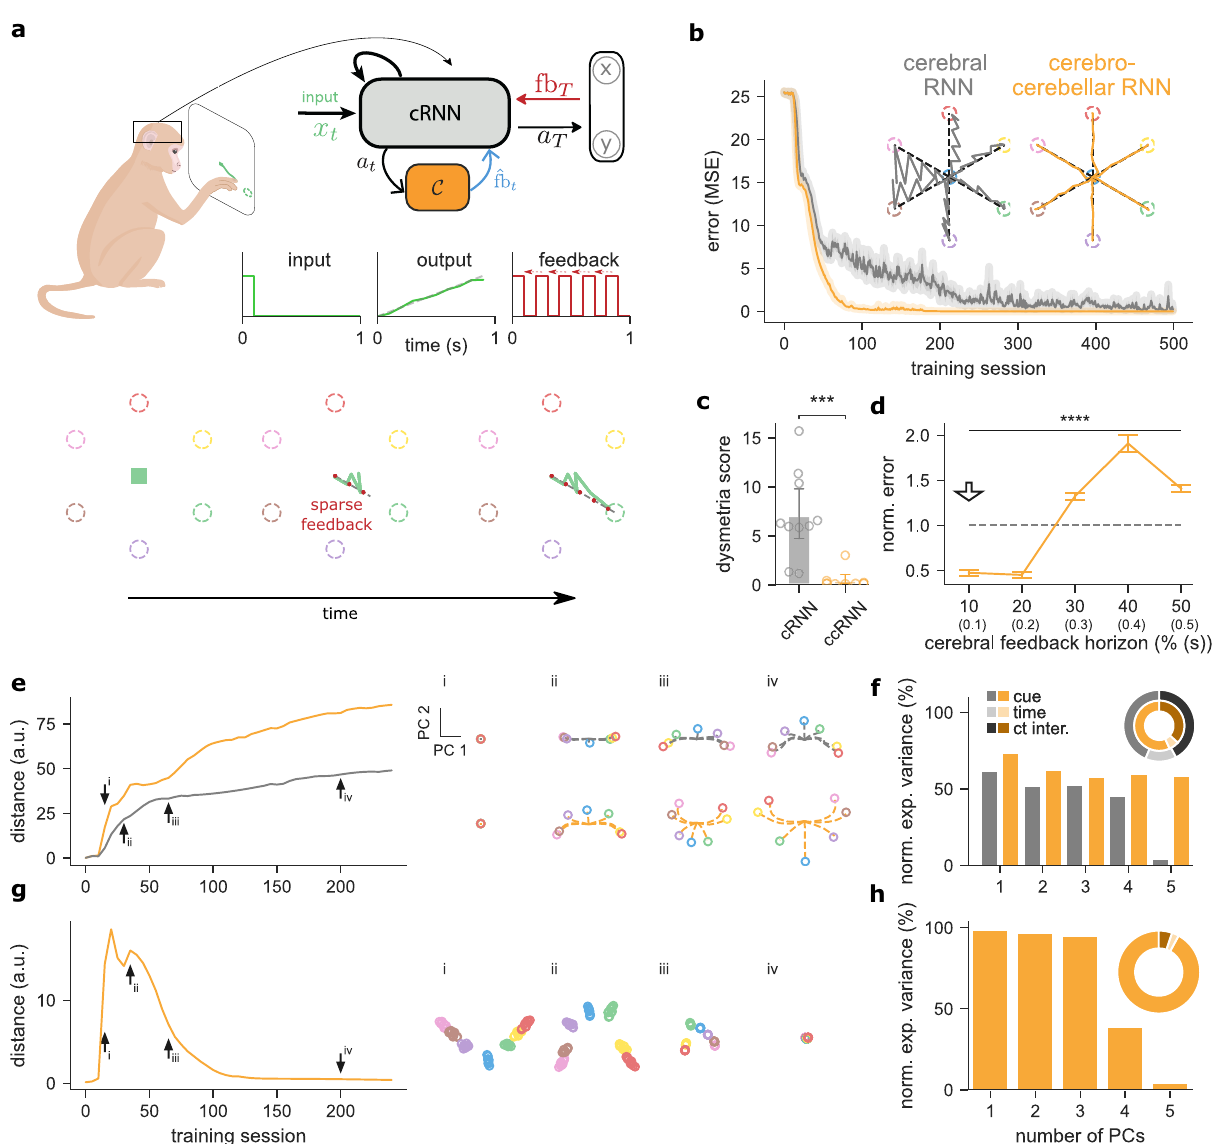
(grey) and ccRNN (orange) models. Arrows highlight training sessions of cue- speci fi c demixed principal components (dPCs) plotted on the right for early (i), early-mid (ii), mid (iii) and late (iv) learning, for both cRNN (top) and ccRNN (bot- tom). Dashed lines represent the trajectory of the 2D neural dynamics throughout the task (circle represents last timestep). f Normalised cue-speci fi c explained var- ianceoftheRNNforbothcRNN(gray)andccRNN(orange).Circularplotshowsthe total explained variance for cue (medium-dark colours), time (light colours) and cue-time interaction (dark colours) task variables. g Euclidean distance of the cue- speci fi ctwo-dimensionalneuralactivity for the cerebellarnetwork(orange, ccRNN model).Arrowsindicatetrainingsessionshighlighted ontheright(i – iv)as in( e ).In contrast to the cerebral network ( g ) here there is no task trajectory enco- ded — multiplecirclesrepresentthetemporalpointsduringthetask. h Normalised explained variance for cue-speci fi c dPCs of the cerebellar network. Circular plot colour-coding same as ( f ). *** p <0.001, **** p <0.0001 (two-sided paired t -test between cRNN and ccRNN). The animal drawing used in ( a ) is available at https:// www.scidraw.io/drawing/445 with a Creative Commons license (https:// creativecommons.org/licenses/by/4.0/). Error bars represent mean±SEM across 10 different initial conditions. Source data are provided as a Source Data fi